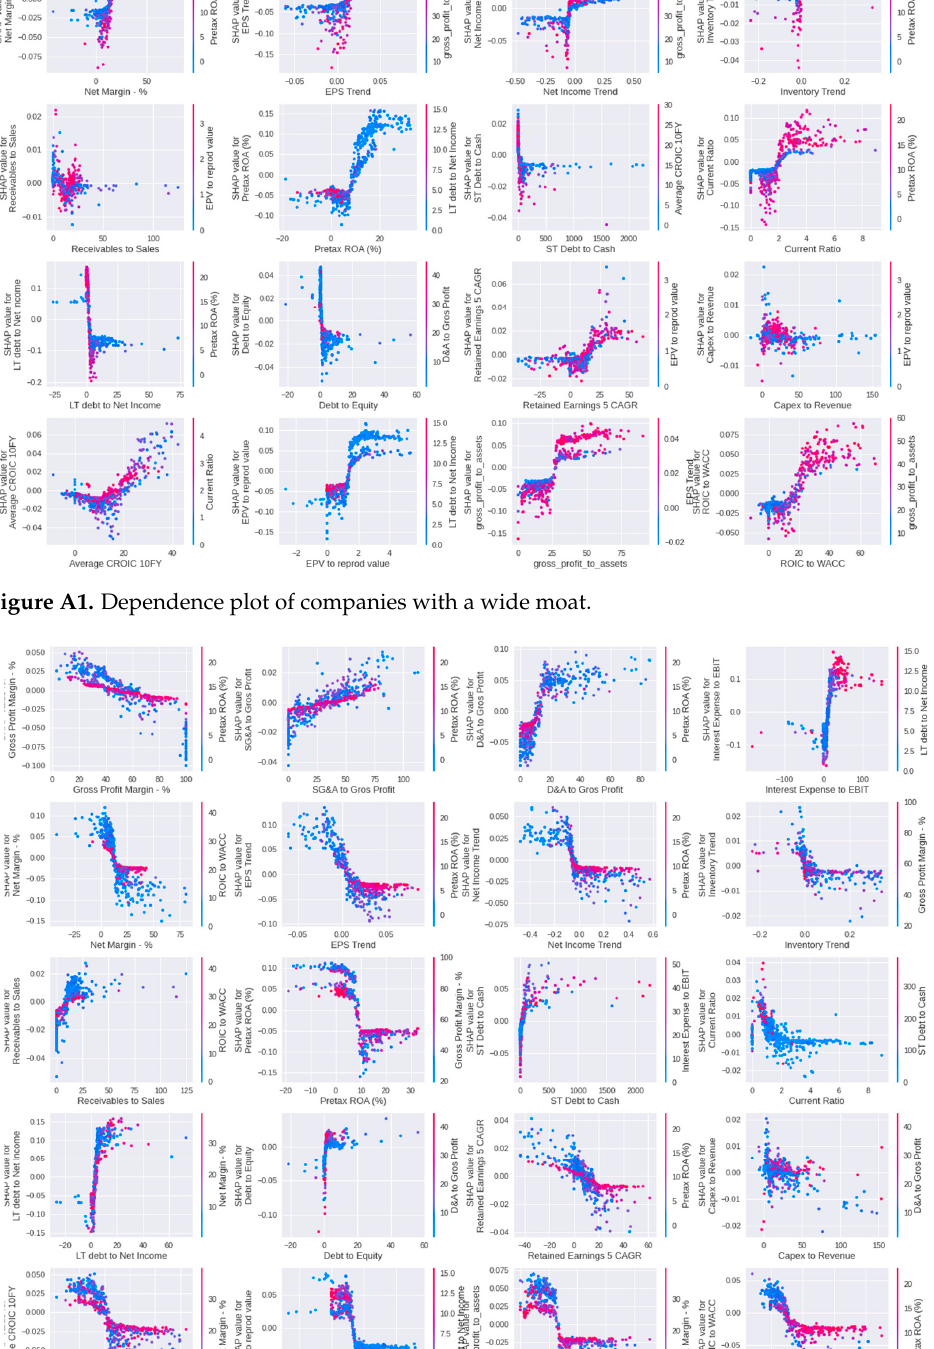
Figure A3. Dependence plot of companies with no moat.